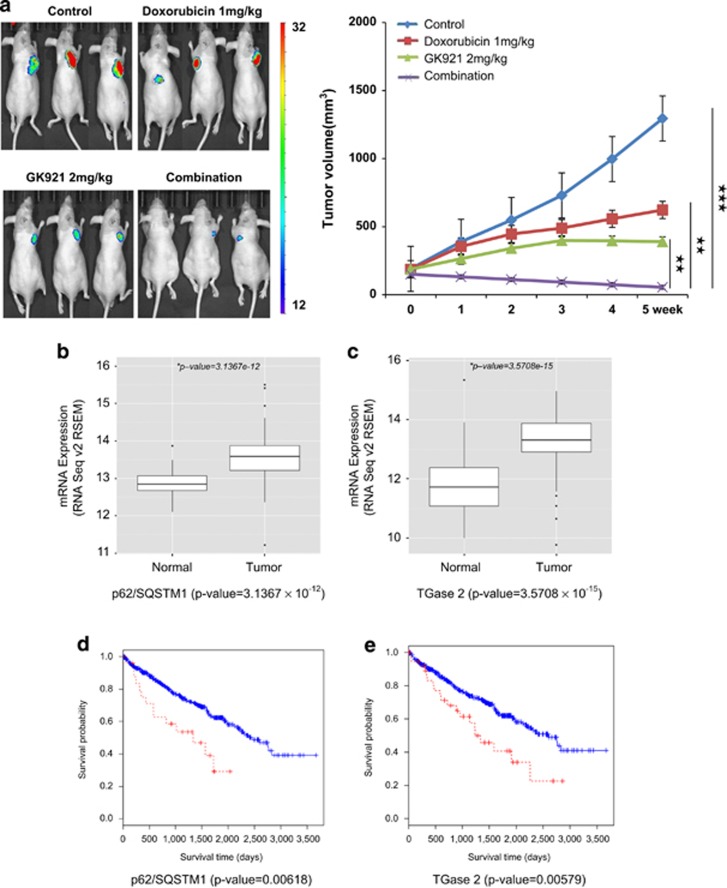
Doxorubicin amplifies the therapeutic response of RCC to the TGase 2 inhibitor GK921. (a) ACHN-luciferase cells were injected subcutaneously into 6–8-week-old female BALB/c nude mice. When the tumor volume reached 100 mm3, mice were treated orally, 5 days/week, with GK921 (2 mg/kg/day), doxorubicin (1 mg/kg/day), both or vehicle (n=3 per each group). After 5 weeks of treatment, tumor size was measured by the photon flux from luciferin and expressed on a color scale and as photons/s/cm2/steradian (left). Tumor volume was also measured using calipers (right). (b–e) Bioinformatics analysis of p62 gene (SQSTM1) and TGase 2 gene (TGM2) expression in clear cell RCC patients. (b) Lower p62/SQSTM1 expression in normal kidney samples than in matched clear cell RCC samples (P=3.1367 × 10−12). (c) Lower TGM2 expression in normal kidney samples than in matched clear cell RCC samples (P=3.5708 × 10−15). (d) Patients with high levels of p62/SQSTM1 expression (red) had lower overall survival (OS) than those with low levels (blue). Log-rank test, P=0.00618. (e) Patients with high levels of expression of TGM2 (red) also had a reduced OS. Gene expressions are colored red; higher levels of gene expression cut off z-score>2σ. Log-rank test, P=0.00579